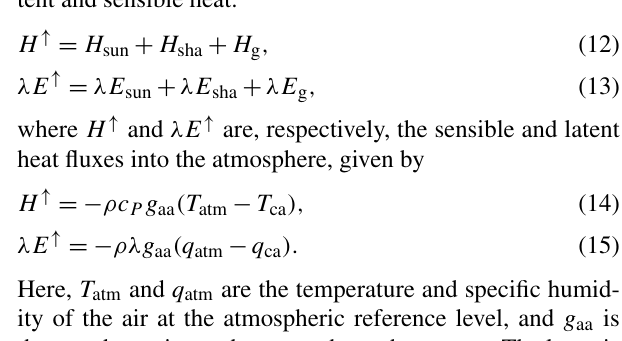
h,sun[sha] is the conductance for w,sun[sha]